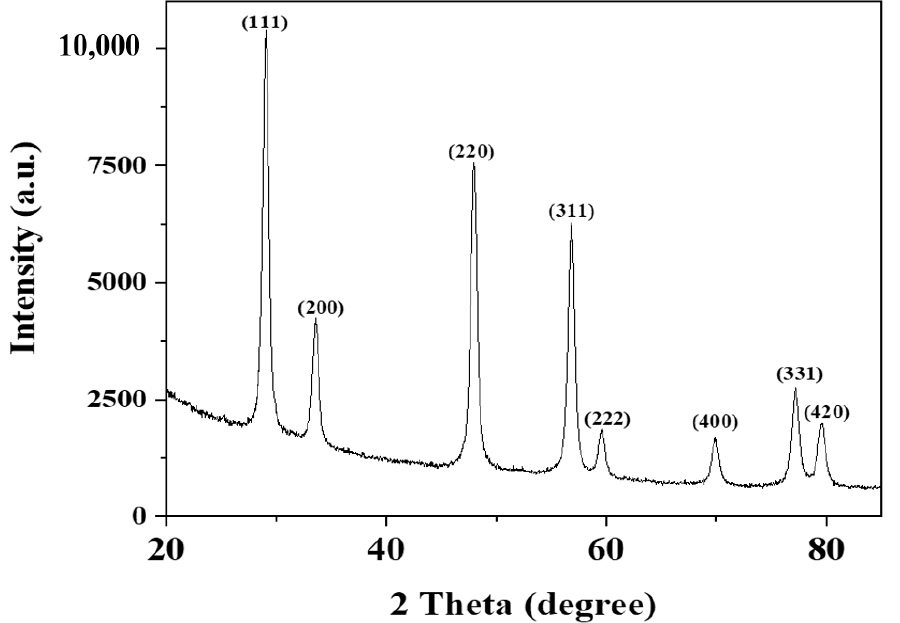
Figure 1. XRD patterns of CeO 2 nanoparticles.